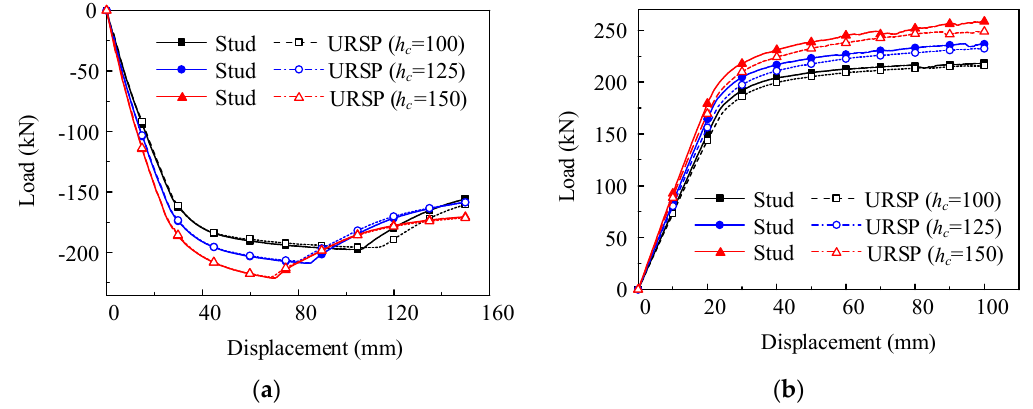
Figure 15. Load-displacement curves with different slab thicknesses h c . ( a ) Hogging moment; ( b ) sagging moment.